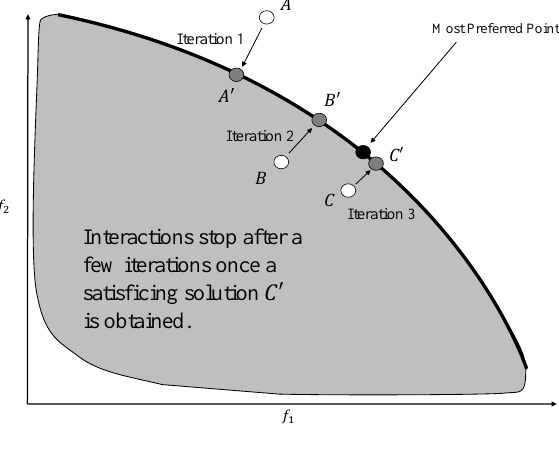
Figure 6. Interaction after a